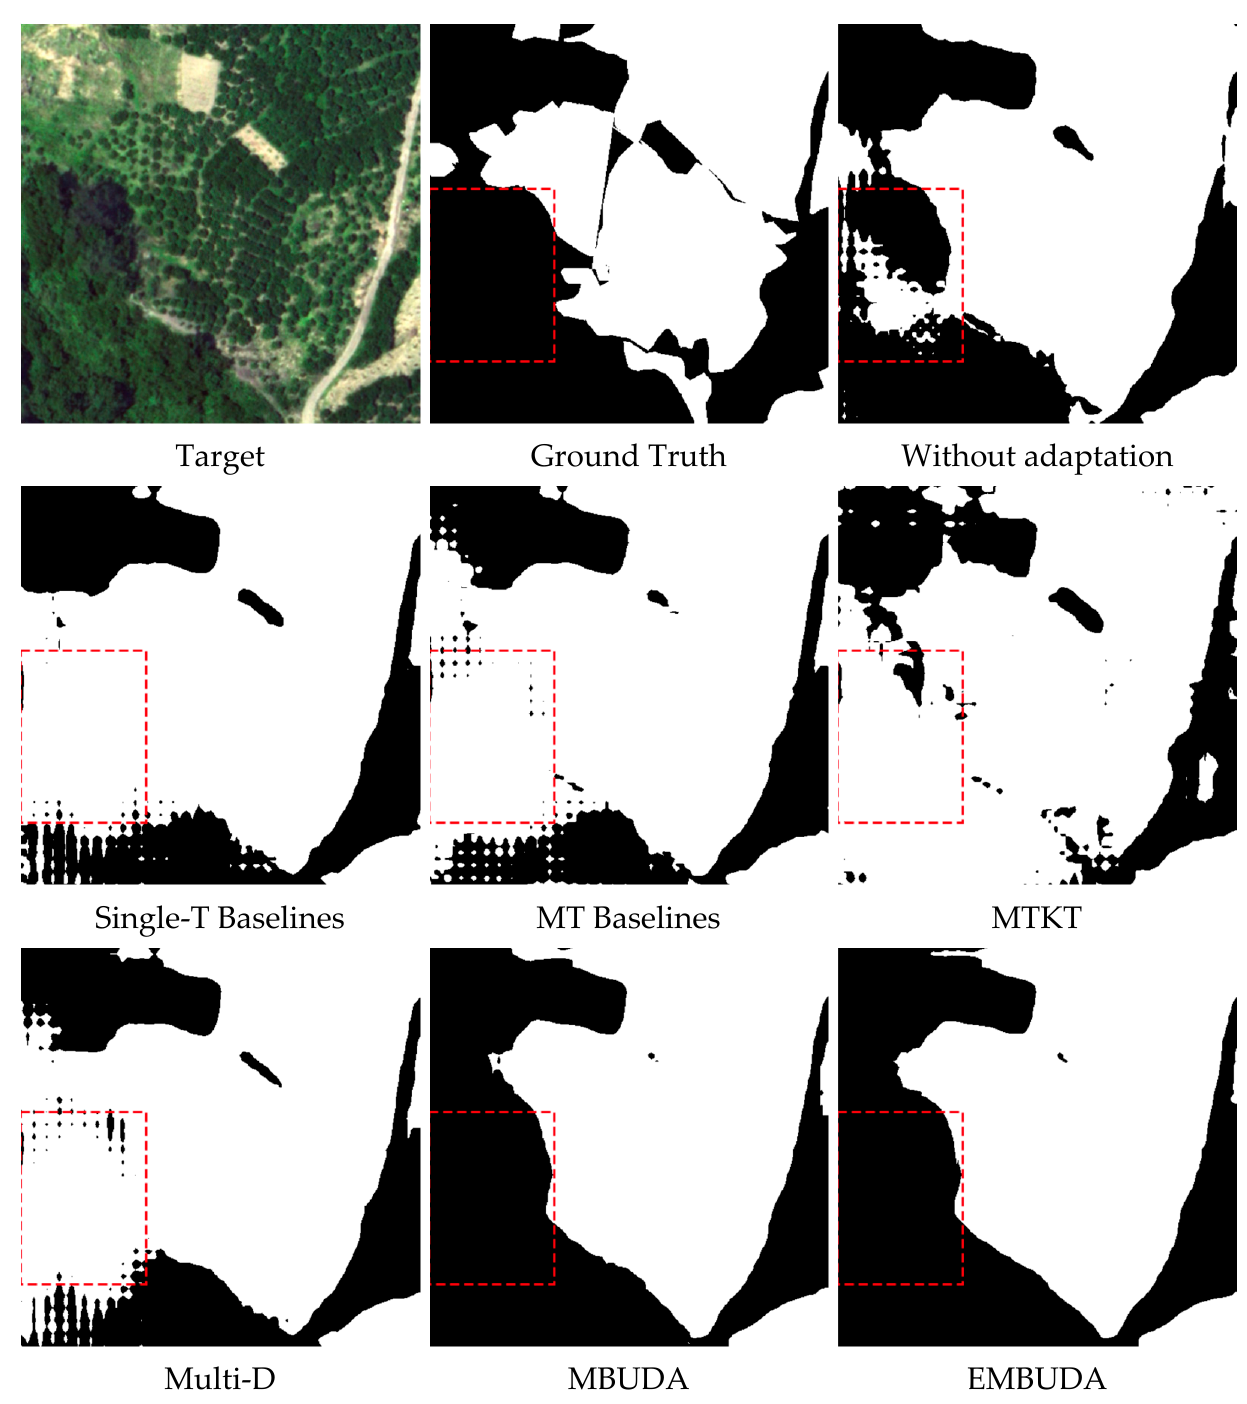
Figure A7. Outputs of orchard area segmentation in Dataset ZG when adapting from Dataset CY to Dataset ZG, Dataset XT1 and Dataset XT2.